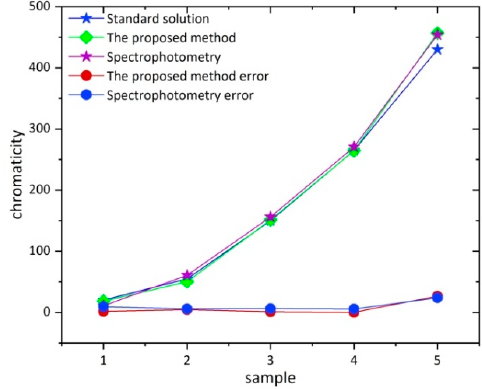
Figure 10. Comparisons of two measurement methods.